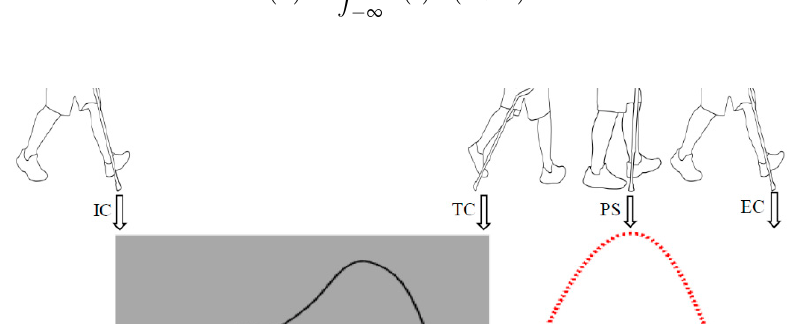
Figure 4. The matched filter output (dotted red line) obtained when correlating the template signal with unknown strain gauge data (solid black line). Figure 5 shows the state machine used for this approach. A matched filter was used to identify the starting state (i.e., IC event) by correlating a known template signal with the unknown strain- gauge data to detect the presence of the template pattern within the data [50]. The template signal was selected at random from a pilot participant’s strain gauge data corresponding to a single stride during flat surface walking (similar to that presented in Figure 3), and was used for all of the varying terrains for all participants. The matched filter outputs distinct positive peaks at instances of IC events. To correctly detect the presence of this template signal within the unknown data, a similarity threshold of 50% was used. Any spurious positive peaks in the matched filter output that showed less than 50% correlation were therefore discarded and not counted as a stride. Identification of a valid positive peak in the matched filter output thus indicated the presence of the template signal in